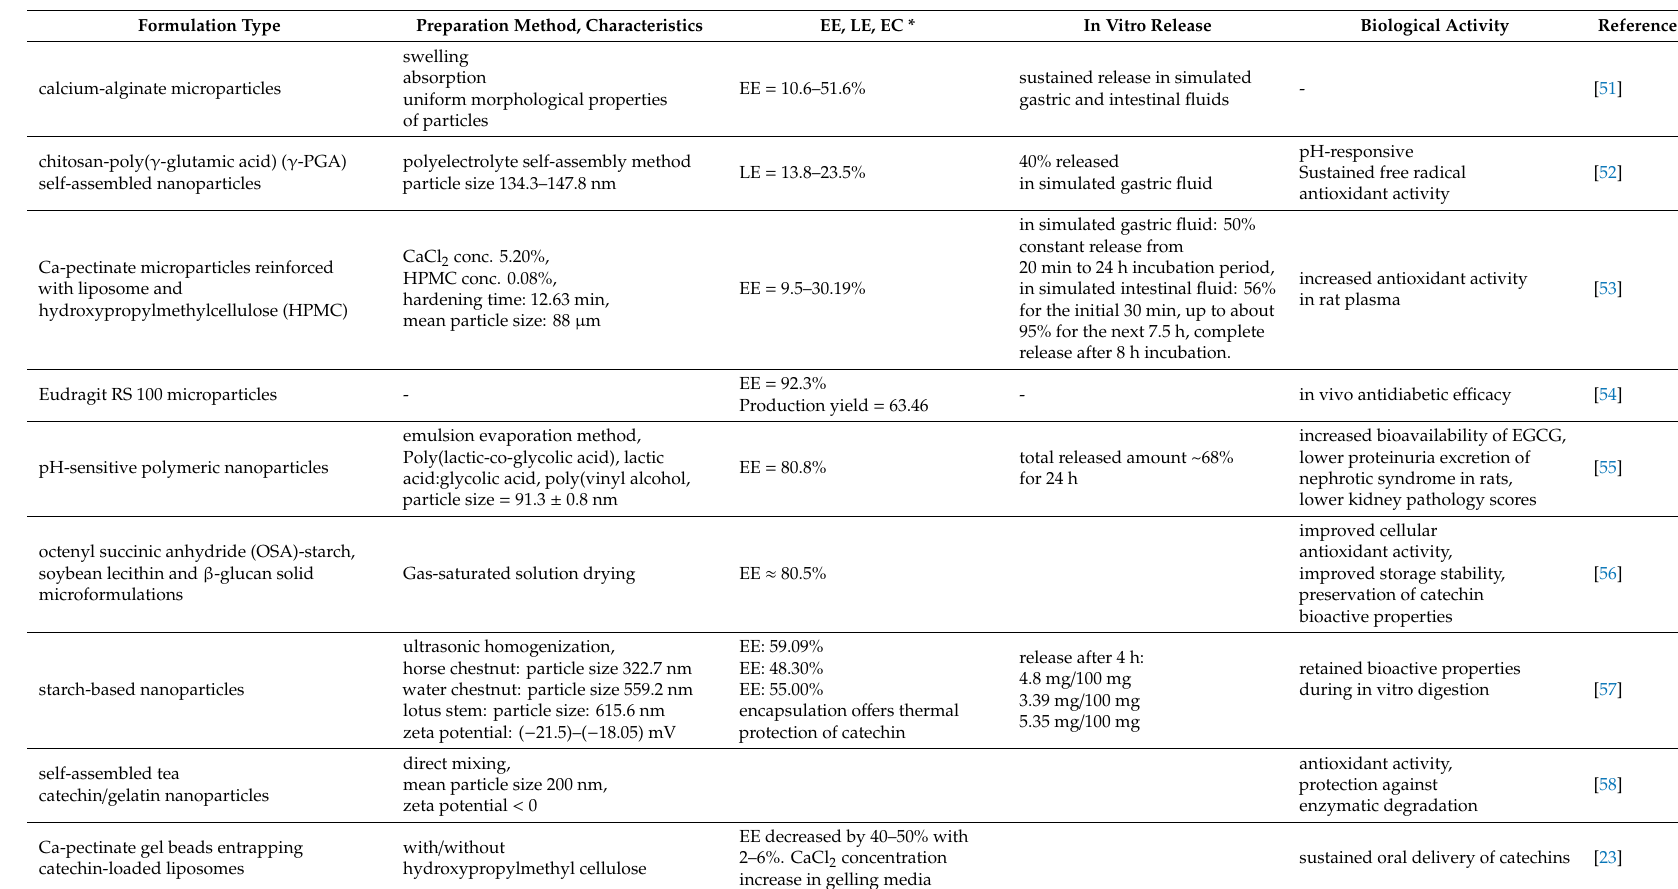
Table 1. E ff ect of encapsulation methodology on the encapsulation e ffi ciency, in vitro release and bioactivity of catechins-loaded biopolymer